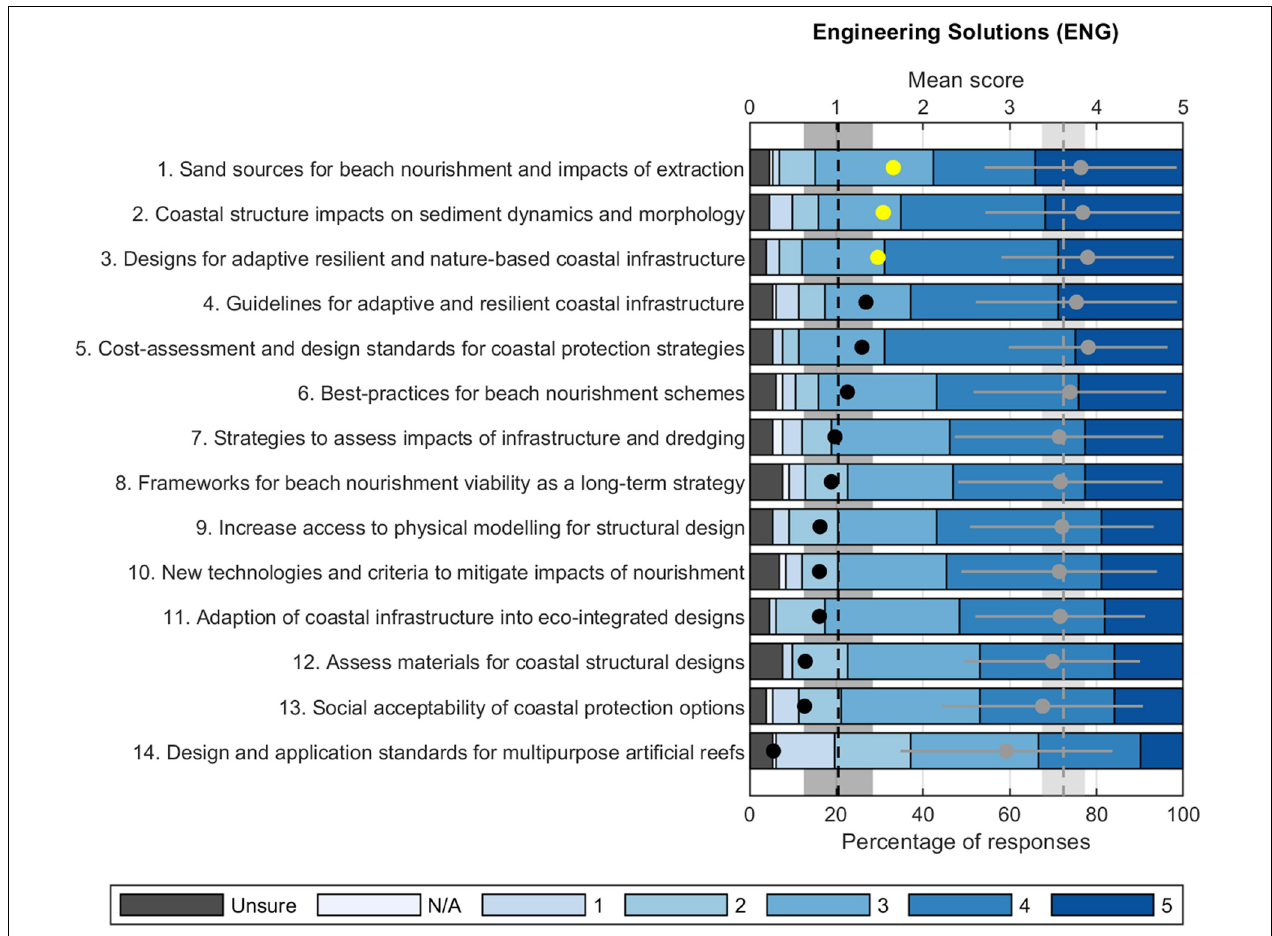
FIGURE 9 | Stacked bar plot showing the distribution of Stage 3 respondent scores for priorities in the Engineering Solutions (ENG) category. See Figure 5 for full caption.